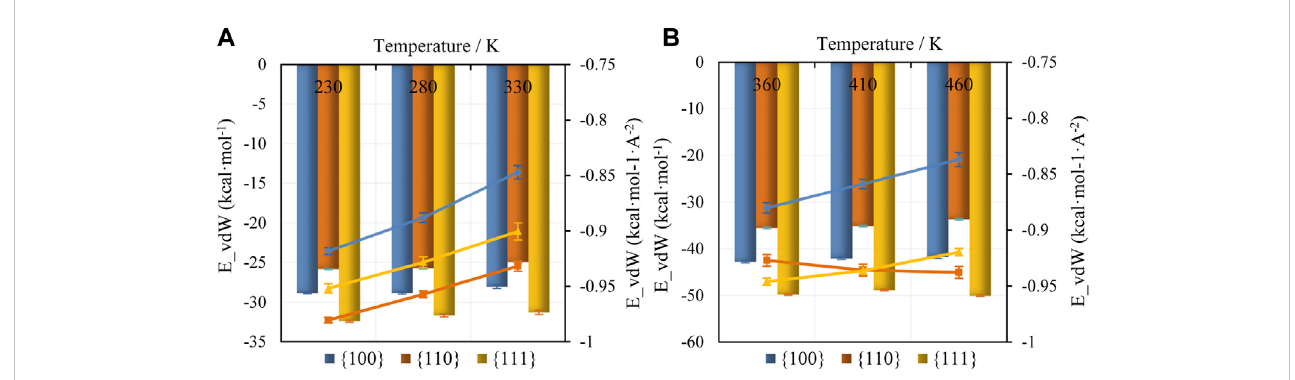
FIGURE 6 Adsorption Energy in the adsorption region for (A) TCE and (B) TCB molecules for different facets and temperatures. Values are shown in units per molecule (bar chart, left vertical axis) and units per unit area (line plot, right vertical axis).